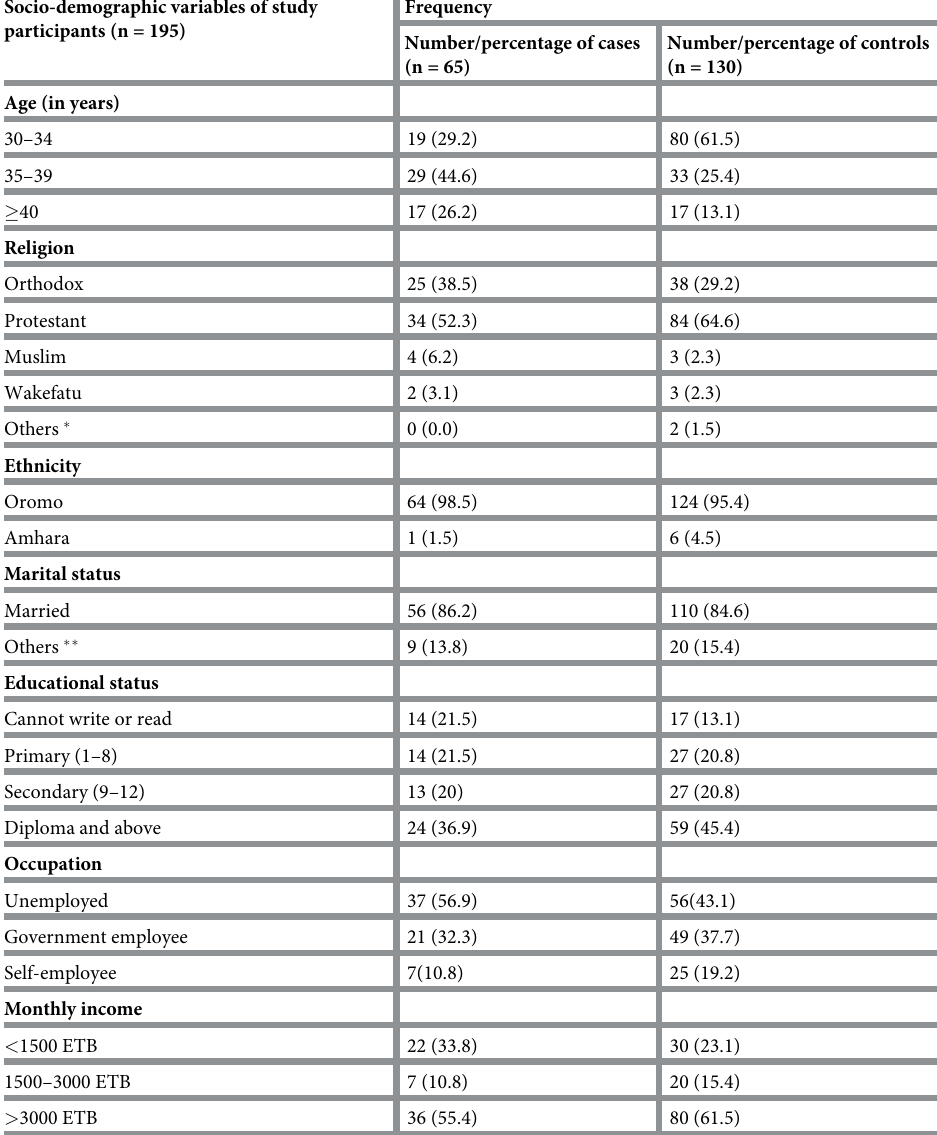
Table 1. Socio-demographic characteristics of women in the age group of 30–49 years in Ambo town, Oromia Regional State, Ethiopia, February to March 2020. Socio-demographic variables of study participants (n =